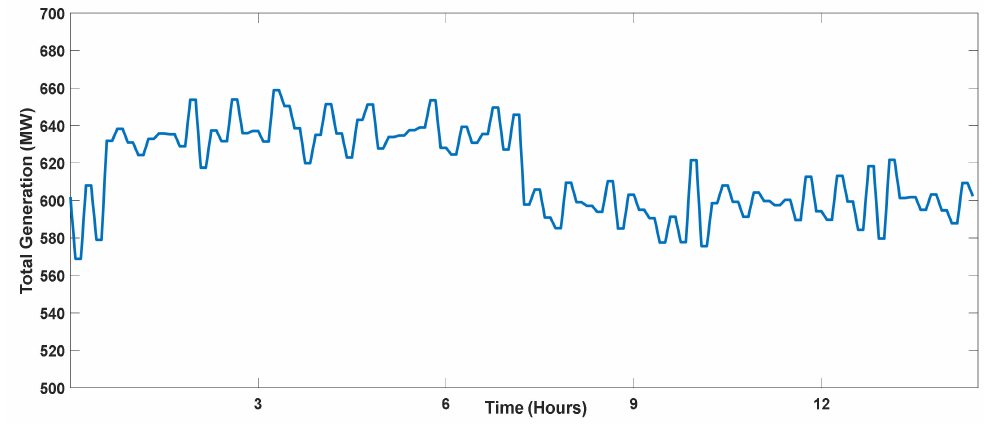
Figure 14. Total Generation.